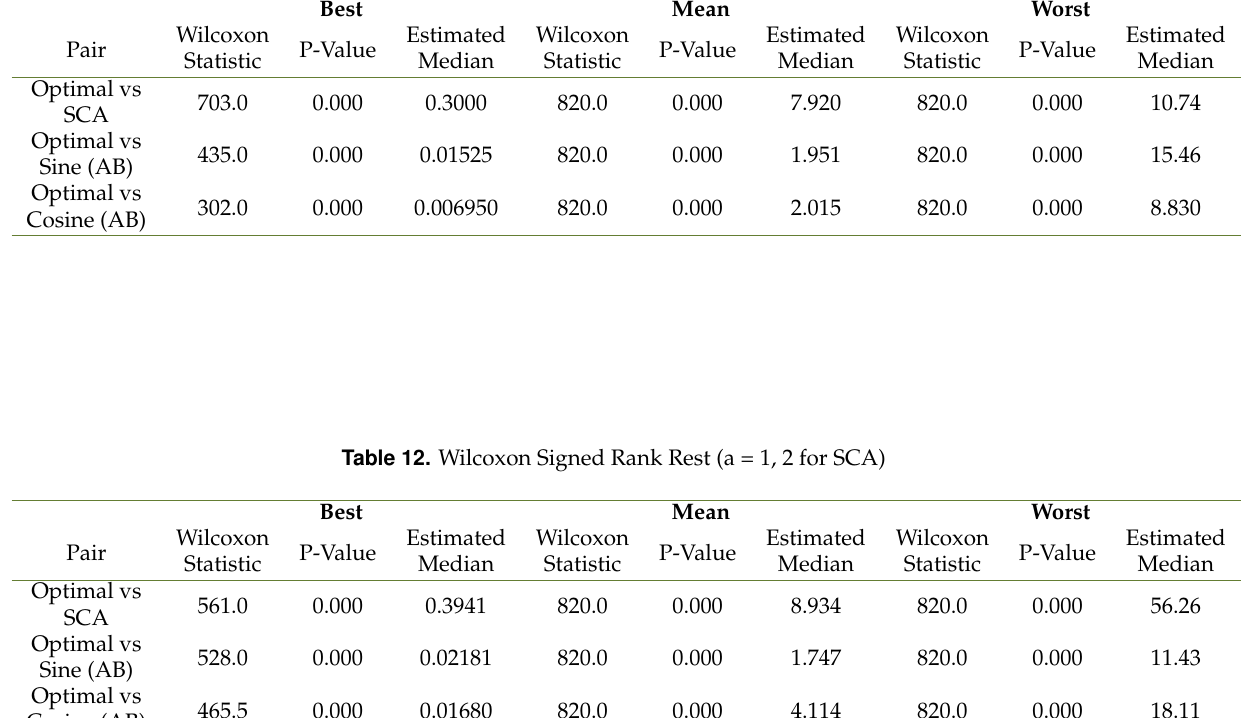
Table 11. Wilcoxon Signed Rank Test (a = 1.5, 3 for SCA)